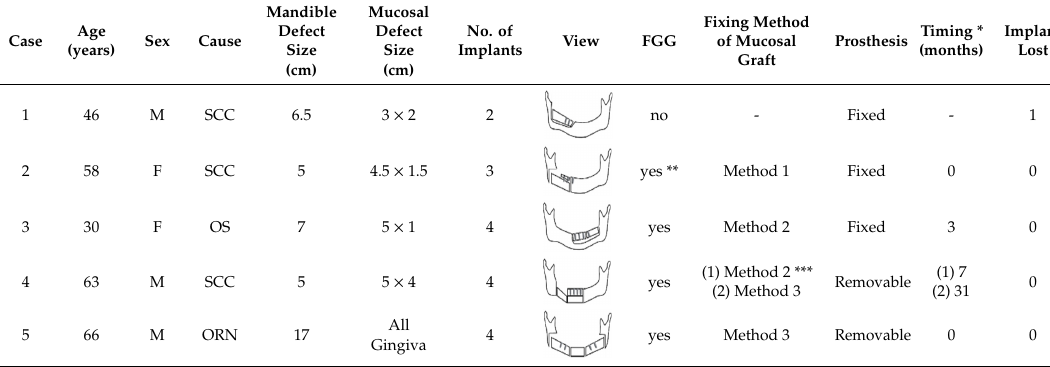
Figure 1. Measurements of keratinized mucosa width (Case 3): keratinized mucosa width was measured on the buccal side ① and the lingual side ② of the implant. Excluding one patient who received mandibular reconstruction for osteoradionecrosis, none of the patients were subjected to radiation treatment. In four of the five patients, skin flap reduction and alveolar bone graft surgery were performed; this was followed by primary/secondary implant surgeries and soft tissue treatment. For the skin flap reduction and alveolar bone graft surgery, the largest possible quantity of fat and other unwanted tissue was removed from the skin flaps, and the fibula was sewn into the lingual and buccal periosteum, forming the alveolar ridge. In addition, there was not enough clearance in one patient; in this case, the fibula was ground down to ensure enough clearance. Two of the other four patients had undergone soft tissue treatment at the same time as their secondary implant surgery. Case 5 required treatment of the entire jaw; therefore, after installing the implants, skin flap reduction, alveolar bone graft surgery and FGG were performed alongside the secondary implant surgery (Table 1). Only Brånemark System Mk III implants (Nobel Biocare, Kloten Sweden) were used in this study.